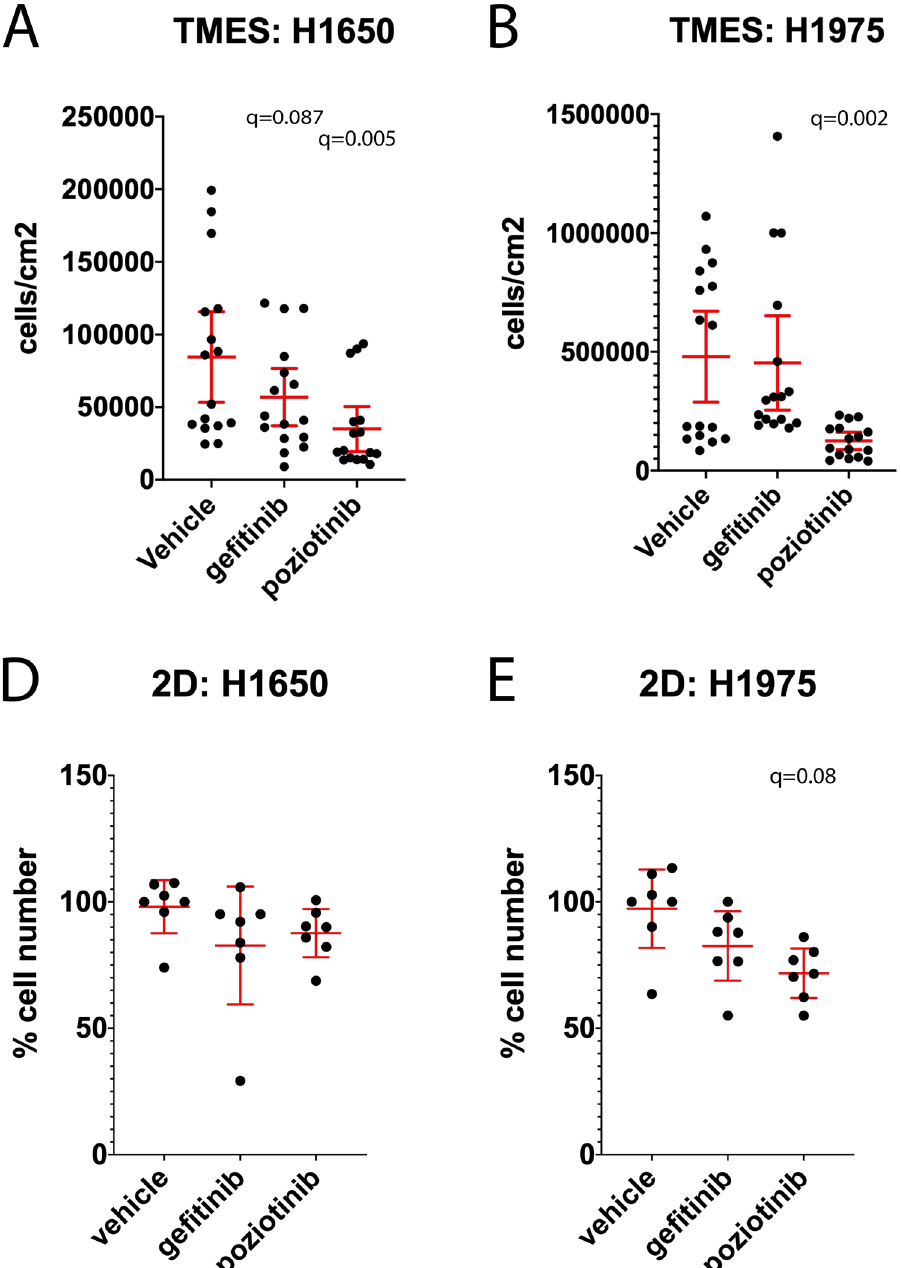
Figure 8. The NSCLC TMES responds to EGFR inhibitors according to EGFR mutational status. NSCLC cells from H1650 ( A , C ) and H1975 ( B , D ) were grown in the TMES for four days and then dosed with either 848 nM gefitinib or 172 nM poziotinib. Tumor cell number was determined using luciferase signal as a surrogate for cell number with a standard curve. Plotted are individual measurements of tumor cells across multiple TMES device runs with the mean and 95% confidence intervals shown in red. ANOVA followed by two stage step up method of Benjamini, Krieger and Yekutieli to control for the FDR, relative to control; q values reported on the